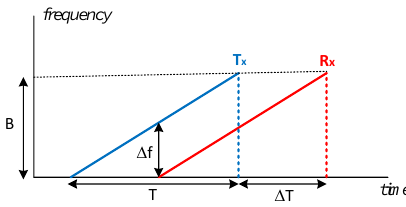
Figure 1. Linear Frequency modulated signal